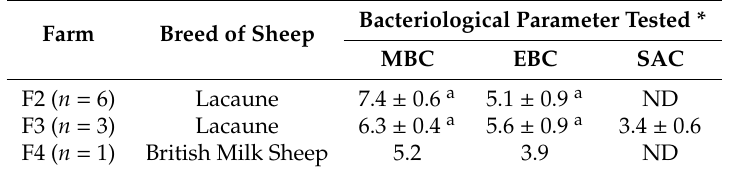
Table 6. Bacteriological quality of bulk tank milk samples according to the farm. Farm Breed of Sheep